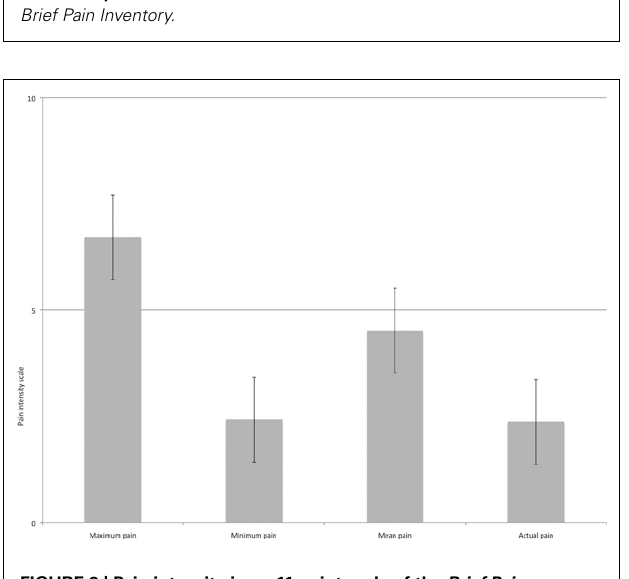
FIGURE 2 | Pain intensity in an 11-point scale of the Brief Pain Inventory (0 = “no pain” e 10 = “the worst pain possible”). The horizontal line defines the median point of the scale